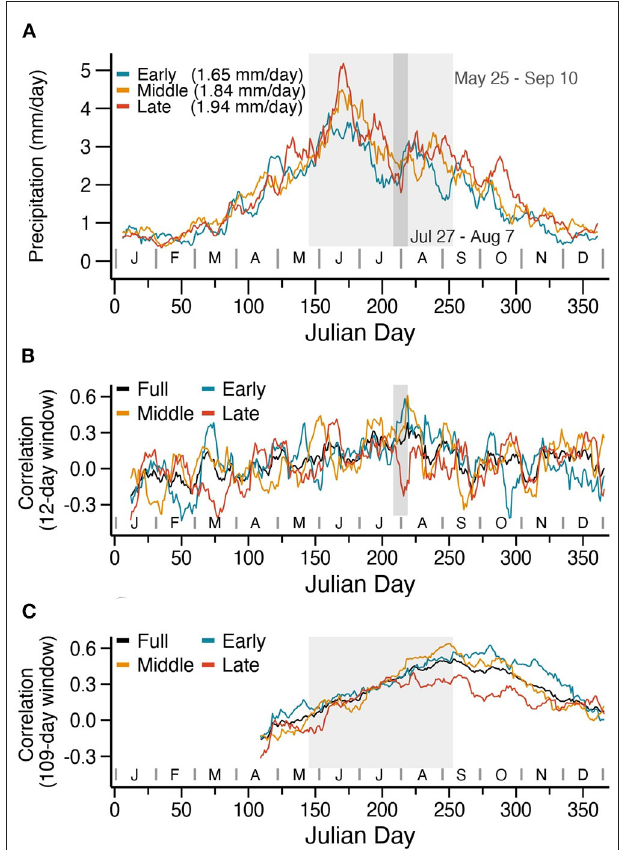
FIGURE 3 | Daily precipitation climatology and tree ring latewood correlations for early (1913–1947, blue), middle (1948–1983, orange), late, (1984–2018, red), and full (1913–2018, black) periods. Eleven-day moving averages of mean daily precipitation (A) . Tree ring correlations with overlapping 12-day precipitation intervals, advancing 1 day at a time (B) . Tree ring correlations with overlapping 109-day precipitation intervals, advancing 1 day at a time (C) . Dark and light gray boxes correspond to the 12-day and 109-day critical climate periods diagnosed in the full period